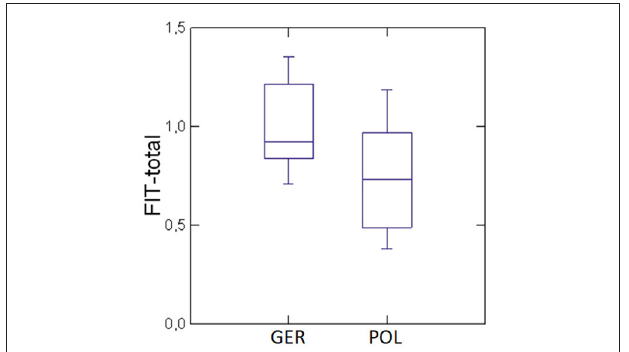
FIGURE 1 | Comparison of the average overall degree of implementation (FIT total score) of the FIT-specific components in the German (“GER”) and Polish (“POL”) study centres. Box plot representation for the distribution of the overall degree of implementation: the bottom and top lines of the groups mark the minimum and maximum values, the horizontal marking within the two boxes represents the median and separates the box into a lower and an upper quartile.